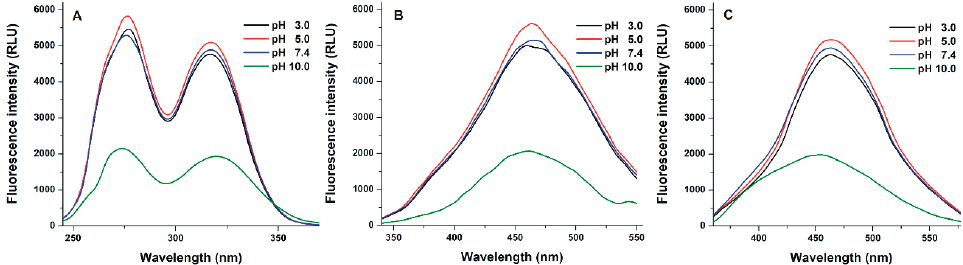
Figure 2. Fluorescence spectra of Z14G. ( A ) Excitation spectra of Z14G (20 µM) in different buffers ( λ em = 455 nm); ( B ) emission spectra of Z14G (20 µM) using 275 nm excitation wavelength; ( C ) and emission spectra of Z14G (20 µM) applying 315 nm excitation wavelength. (Buffers used: 0.05 M sodium phosphate, pH 3.0; 0.05 M sodium acetate, pH 5.0; 0.05 M sodium phosphate, pH 7.4; 0.05 M sodium borate, pH 10.0).